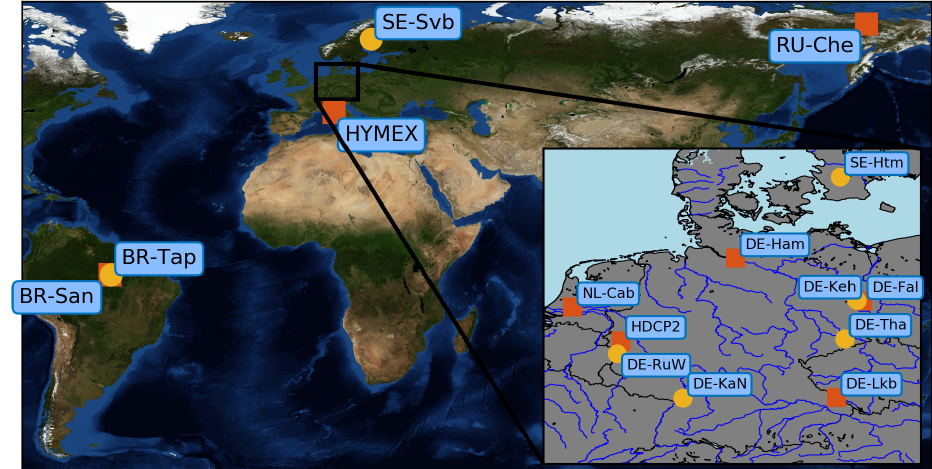
Figure 1. Location of the stations that provided data for this study. Station symbols represent low (red square; grasslands, croplands and wetlands) and tall (yellow circle; forest) vegetation. HDCP2 includes the DE-Nie07, DE-Nie13 and DE-Was06 stations, and HYMEX includes the FR-CorX and FR-GiuX stations. Further information can be found in Table A1.